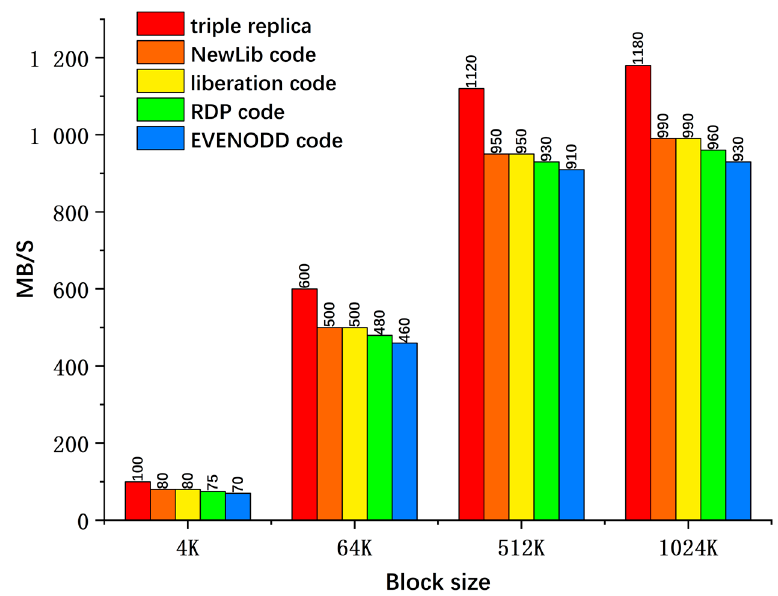
Figure 12. The throughput in the random reading.